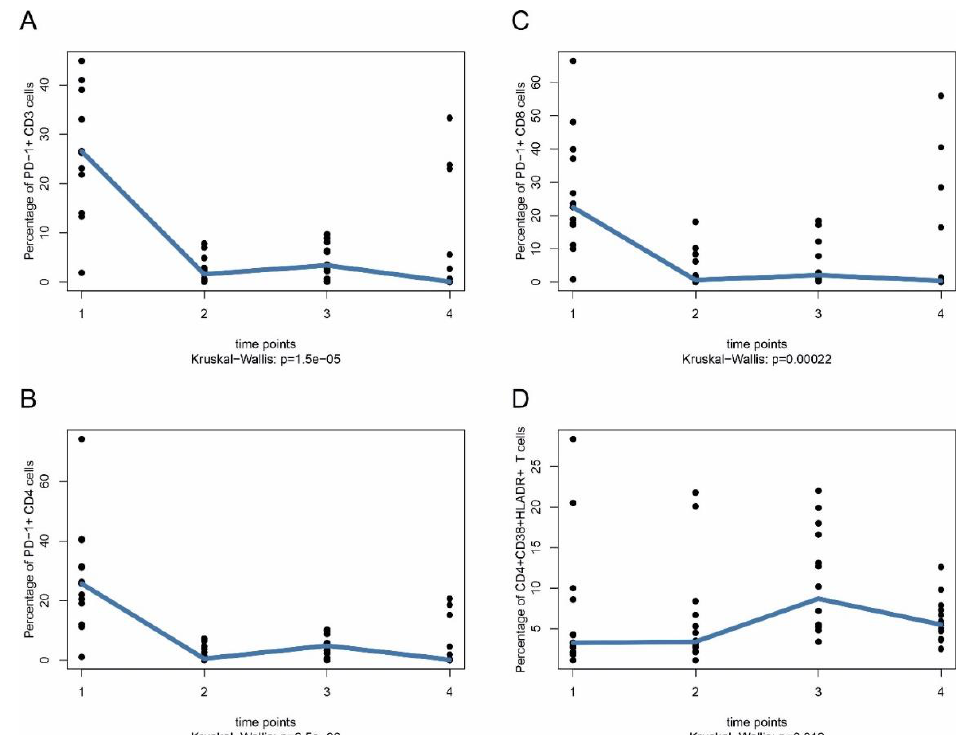
Figure 1. PD-1 expression on T cells in stage IV melanoma patients under ICI therapy. PBMC were taken from patients at indicated time points and PD-1 expression on T cells was analyzed by flow cytometry (FACS). Blood samples were taken immediately before first treatment with anti-PD-1 (either alone or in combination with anti-CTLA-4) (time point 1), immediately after first treatment on the same day (time point 2), after two or three weeks (time point 3) and after three months (time point 4). ( A ) PD1 + CD3 + T cells. ( B ) PD1 + CD4 + T cells. ( C ) PD1 + CD8 + T cells. ( D ) CD4 + CD38 + HLADR + T cells. Nominal (unadjusted) p -values are shown without adjustment for multiple testing. Data in